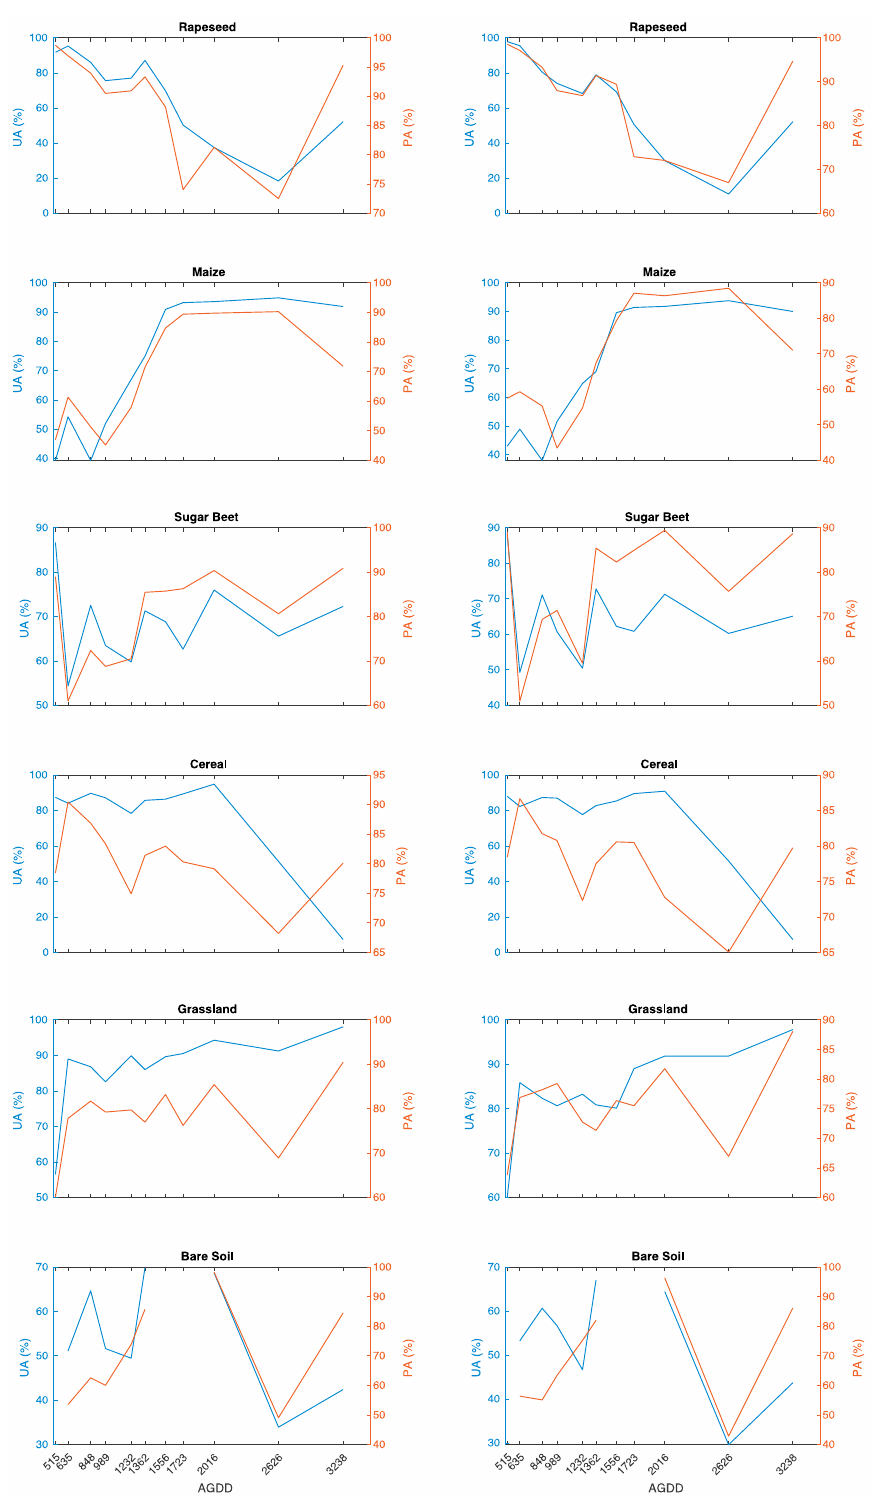
Figure 3. User accuracy (UA) and producer accuracy (PA) of the single crop types for all observation dates, represented as accumulated growing degree days (AGDD) for the NIR-RGB setting ( left ) and the RGB setting ( right ). Different scales for UA and PA apply for the two settings and individual crops. The discrimination of sugar beet is most e ff ective at 515 AGDD with a UA of more than 85%. At 635 AGDD, its discrimination is most di ffi cult with a UA of less than 55%. From 848 AGDD